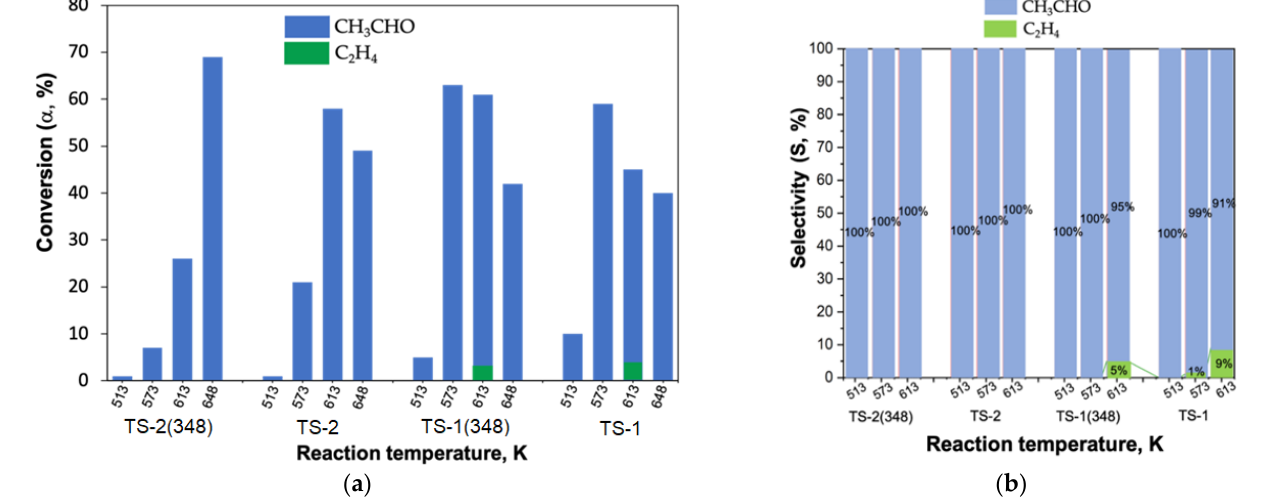
Figure 23. Conversion ( α ,%) ( a ) and selectivity (S,%) ( b ) of ethanol (data from [33]).